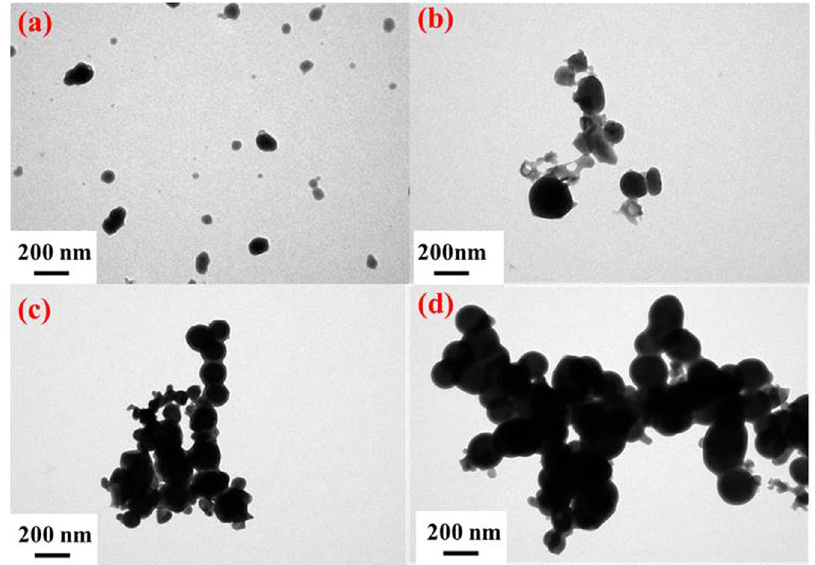
Figure 9. TEM pictures of GeAs ultrafine particles prepared at ( a ) system pressure = 1000 Pa; ( b ) system pressure = 5000 Pa; ( c ) system pressure = 10 4 Pa; ( d ) system pressure = 10 5